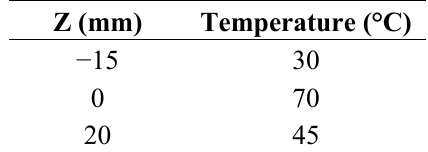
Table 5. Temperature distribution